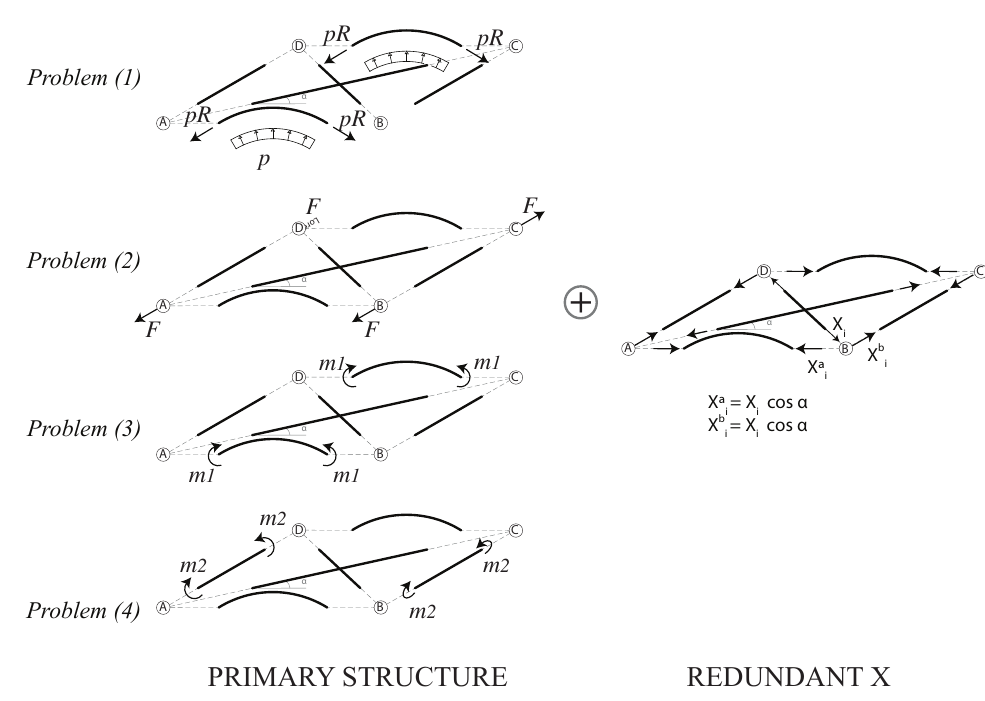
Figure 5. Scheme of the Force Method used to solve the four fine problems. ( Left ) The four different primary structures, one for each problem. ( Right ) The auxiliary structure, characterized by the redundant reaction X